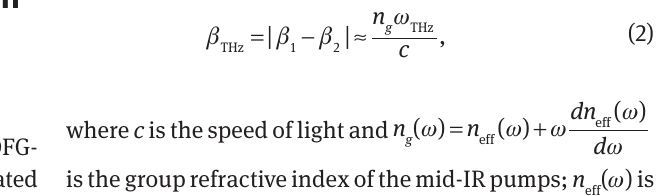
and ω . The device layers are, 1 2